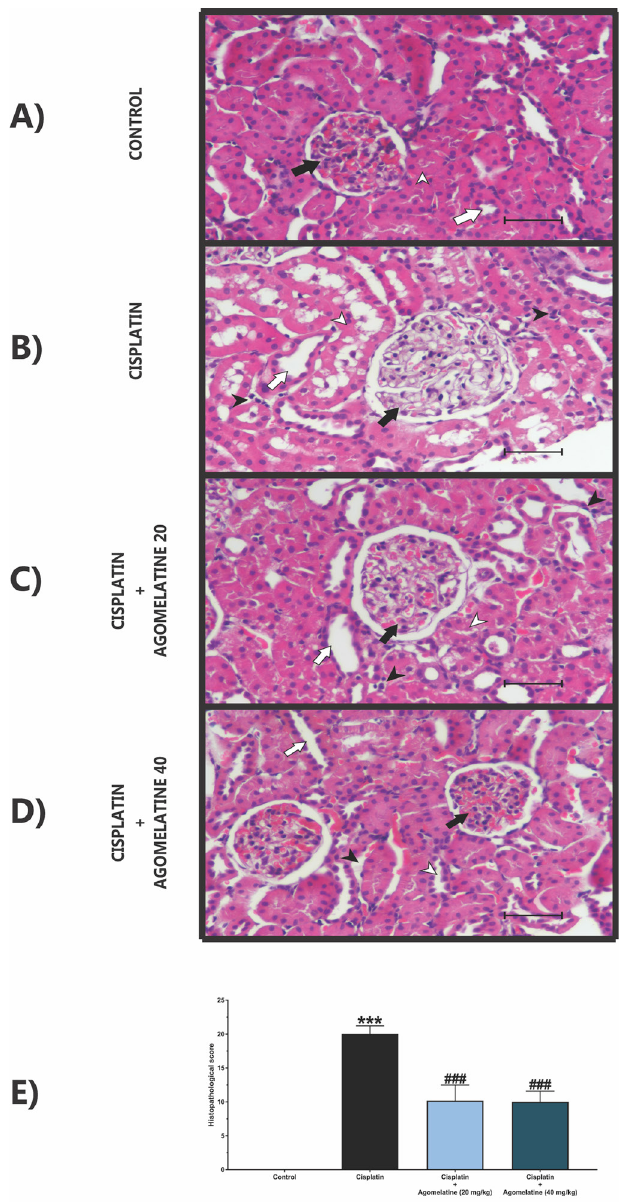
FIGURE 4 - Histopathological presentation of kidney tissue with H&E staining. Scale bar=50 µm with 40x magnification. Standard kidney histology in the control group. Representation of healthy glomerular (black arrow), distal tubule (white arrow) and proximal tubule (arrowhead) (a). Glomerular sclerosis and necrosis (black arrow), dilatation in distal (white arrow) and proximal tubules (white arrowhead) and edema in cisplatin group (b). Compared with the cisplatin group, there were significantly fewer pathological findings in agomelatine 20 and 40 mg/kg groups (c, d). Total histopathological scores of all groups (e). All data represented as mean±SD and stand for three animals per group. *** p<0.001 versus control group and ### p<0.001 versus cisplatin group.